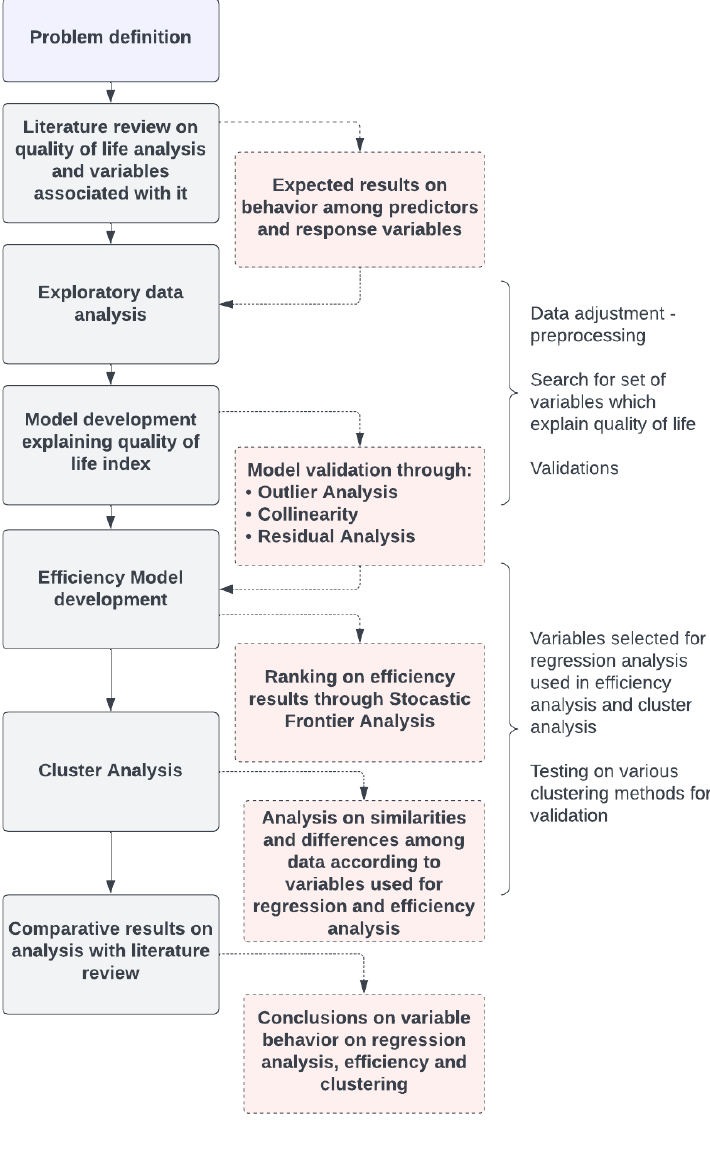
Figure 2. Proposed